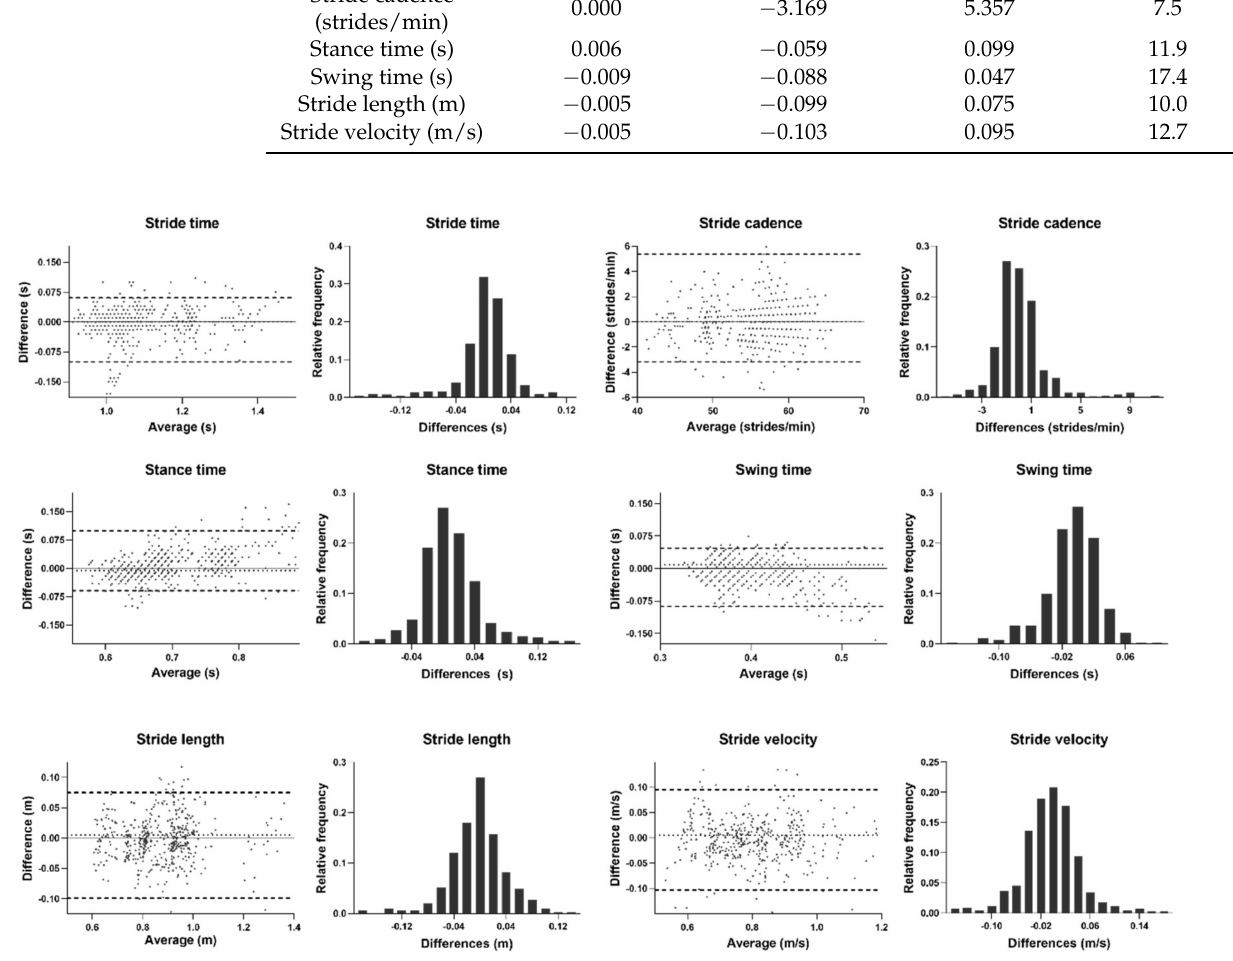
Figure 3. Bland-Altman analysis of the differences between gait metrics obtained in a pants pocket and the optoelectronic criterion versus the median of the two measurements. Distribution plots of differences between methods are presented for each metric. Dashed lines represent bias (median) and the limits of agreement (quantiles 2.5% and